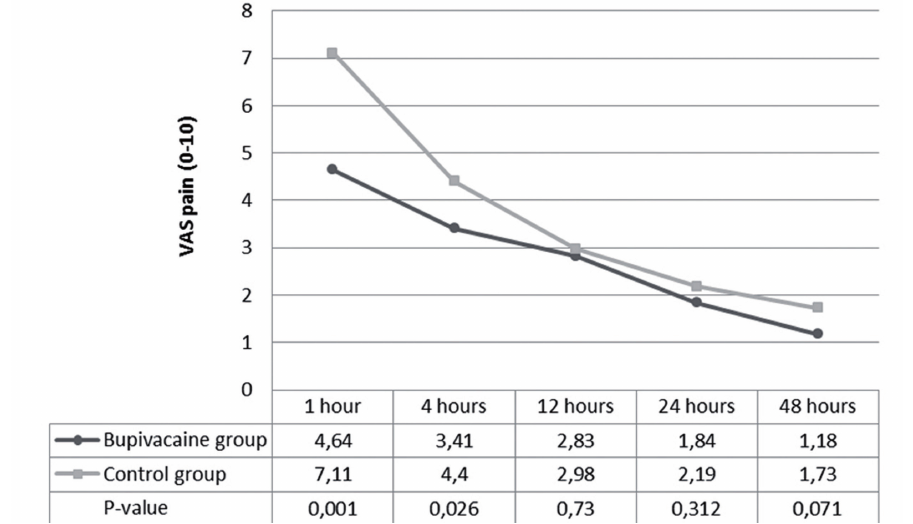
figure 2 - visual Analog score at postoperative times of 1, 4, 12, 24, 48 hours